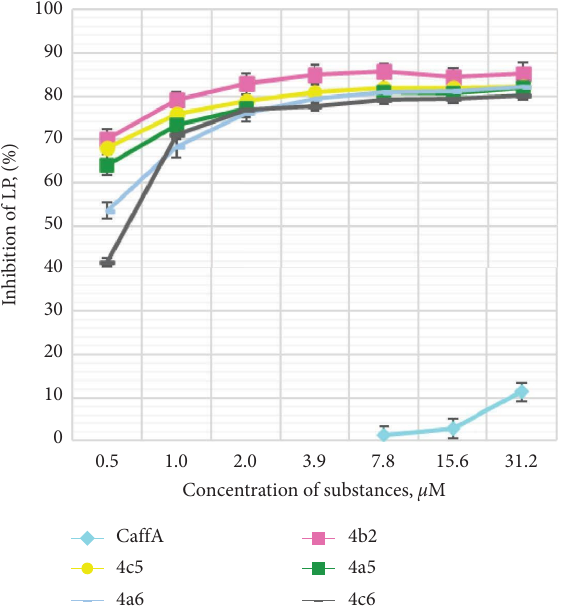
Figure 5: Inhibition of Fe (III)/asc induced lipid peroxidation (LP) in brain homogenate by the tested substances, applied in diferent